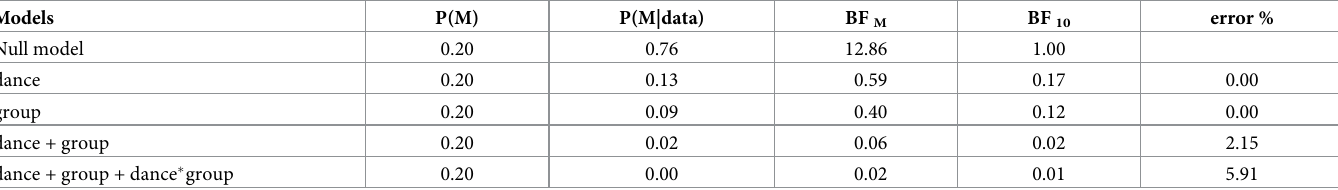
Table 5. Comparison of Bayes models: Dance & group.